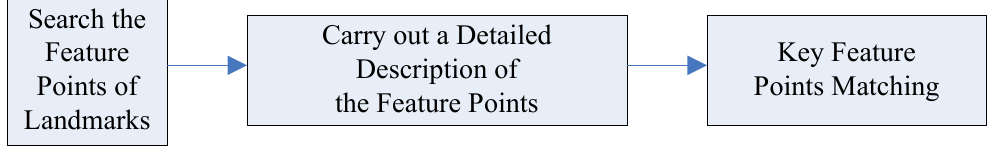
Figure 3. Flow of